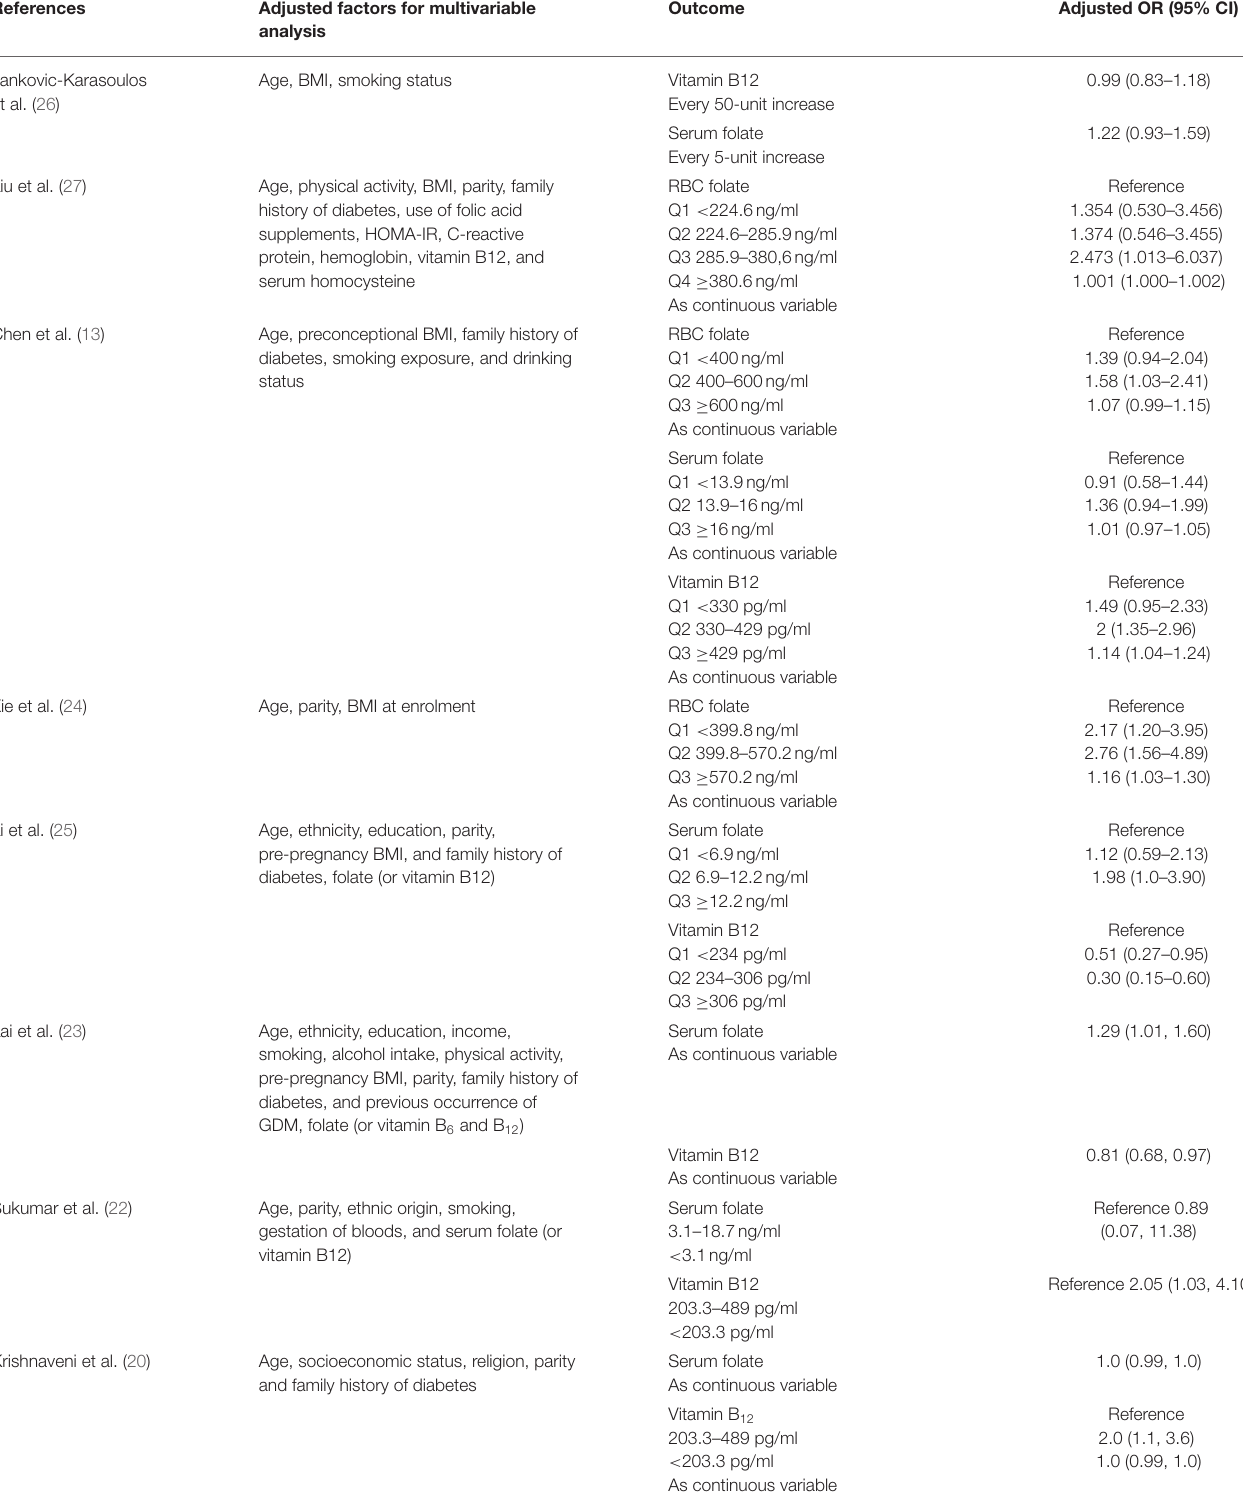
TABLE 2 | Multivariable adjusted Odds ratios from the included